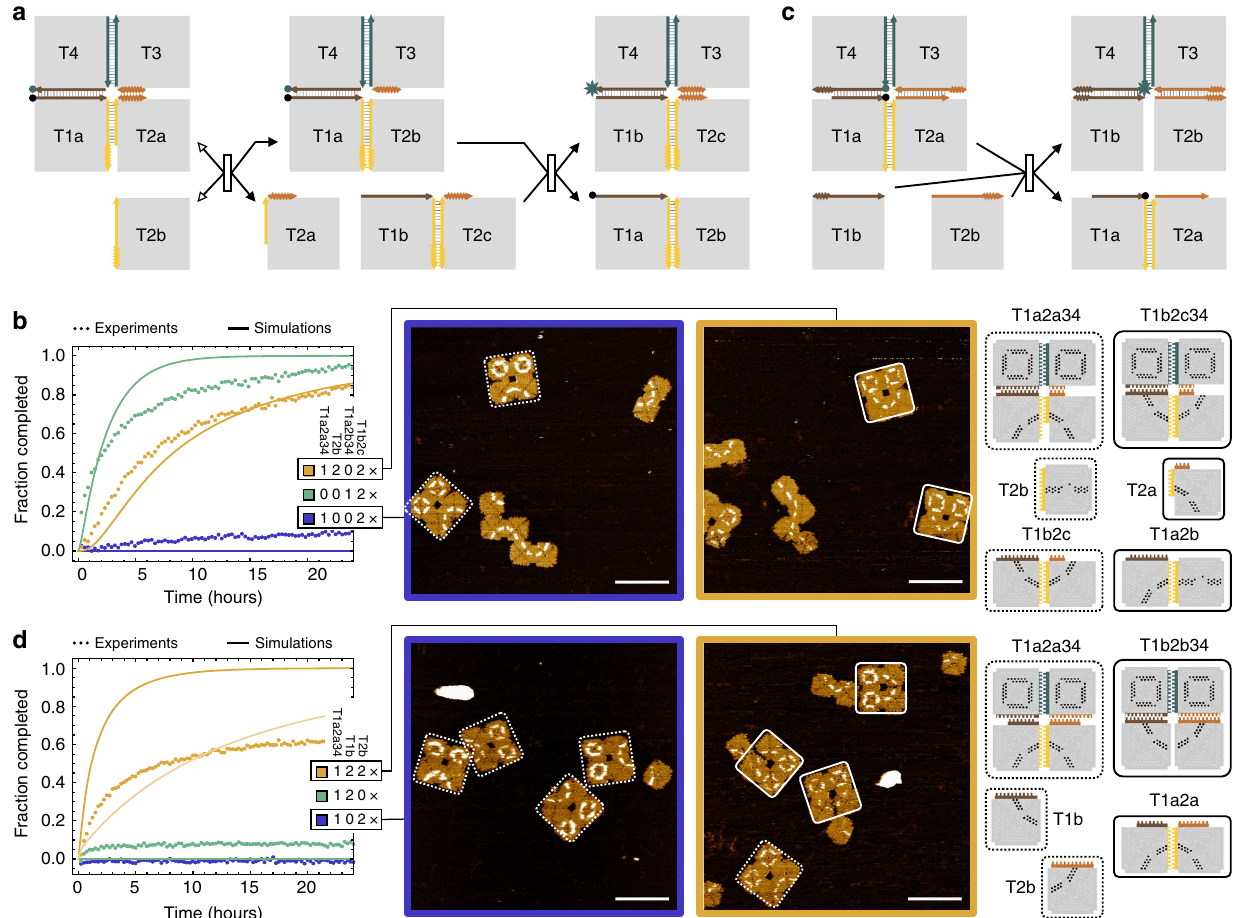
Fig. 3 Sequential and cooperative recon fi guration. a Domain-level diagram of two reactions that take place in a cascade to fi rst displace a single tile and then displace two tiles from a 2 by 2 array. Toehold and branch migration domains with unique sets of edge staples are in distinct colors. Arrows with black- fi lled and white- fi lled arrowheads indicate the forwards and backwards directions of a reaction step, respectively. b Fluorescence kinetics experiments, simulations, and AFM images of sequential tile displacement. Species names of multi-tile complexes are abbreviated by omitting colons and repeated Ts (e.g., T1a2a34 indicates T1a:T2a:T3:T4). Some structures in the AFM images are spurious dimers of invaders (T1b2c) or products (T1a2b),